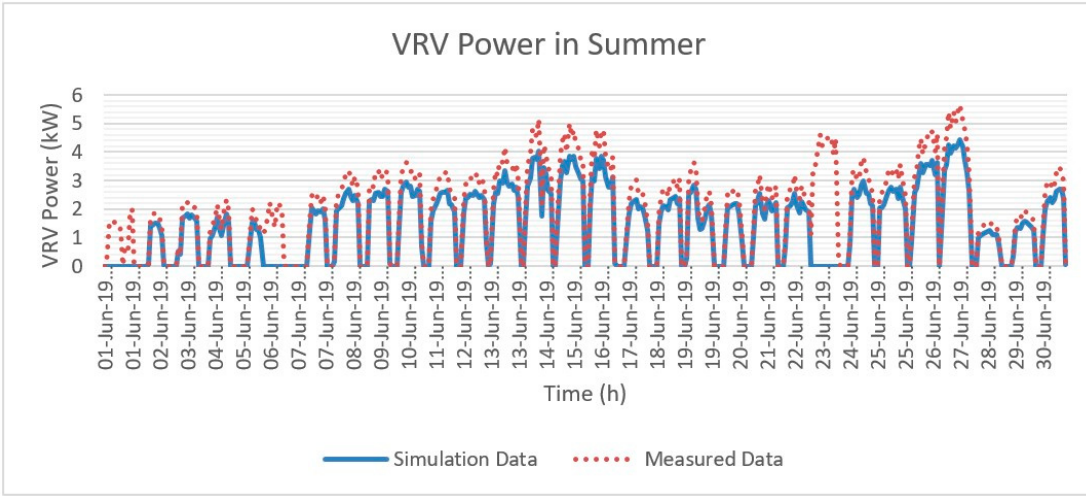
Figure 7. The measured and simulated power consumption in summer.